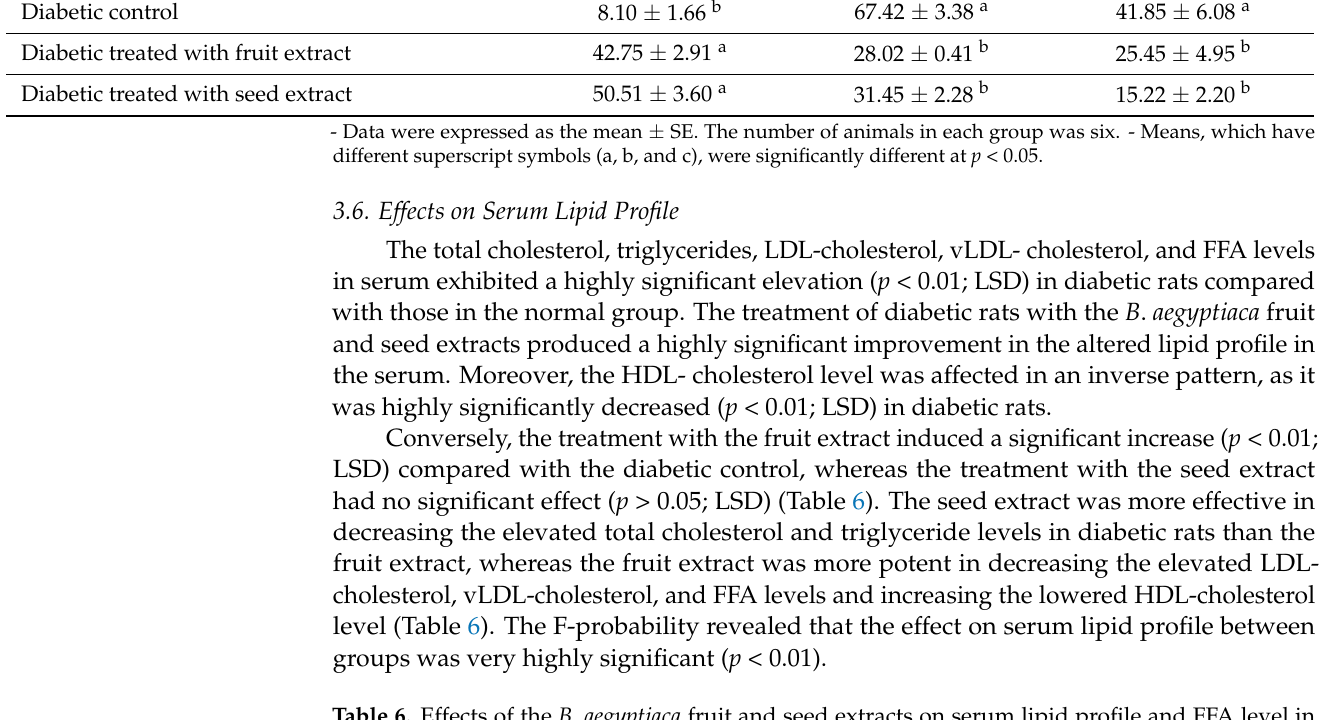
Table 6. Effects of the B . aegyptiaca fruit and seed extracts on serum lipid profile and FFA level in NA/STZ-induced diabetic